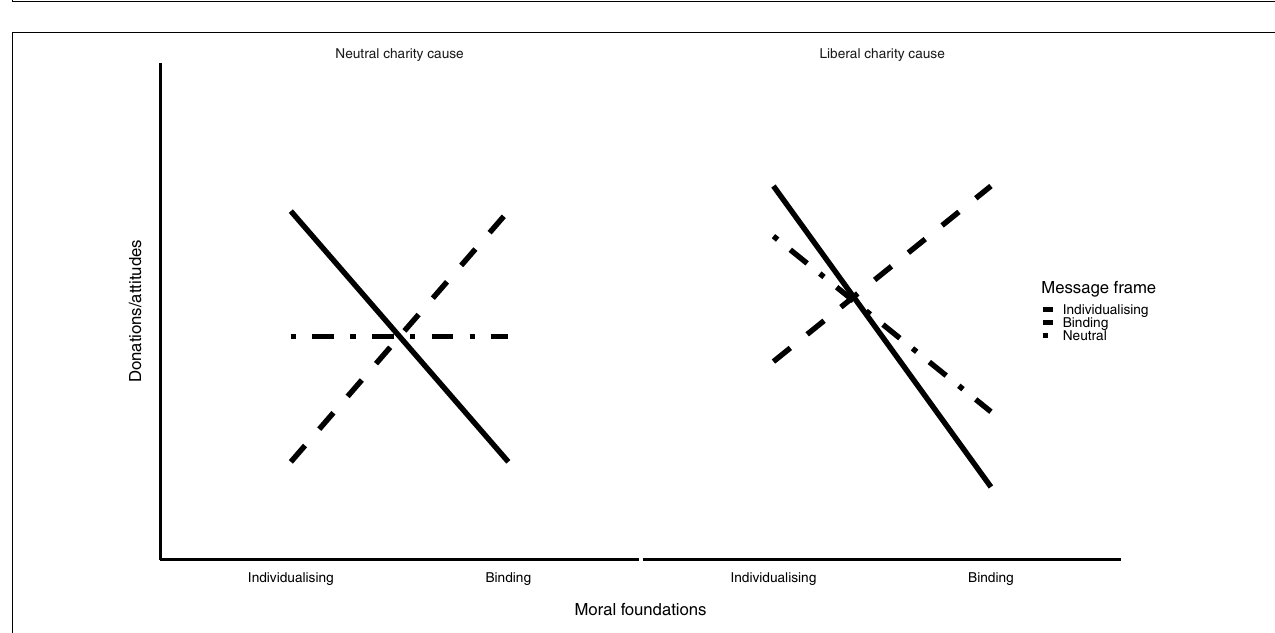
FIGURE 3 | The expected effects of morally (in)congruent calls-to-action and descriptive norms on different levels of moral identity internalization.